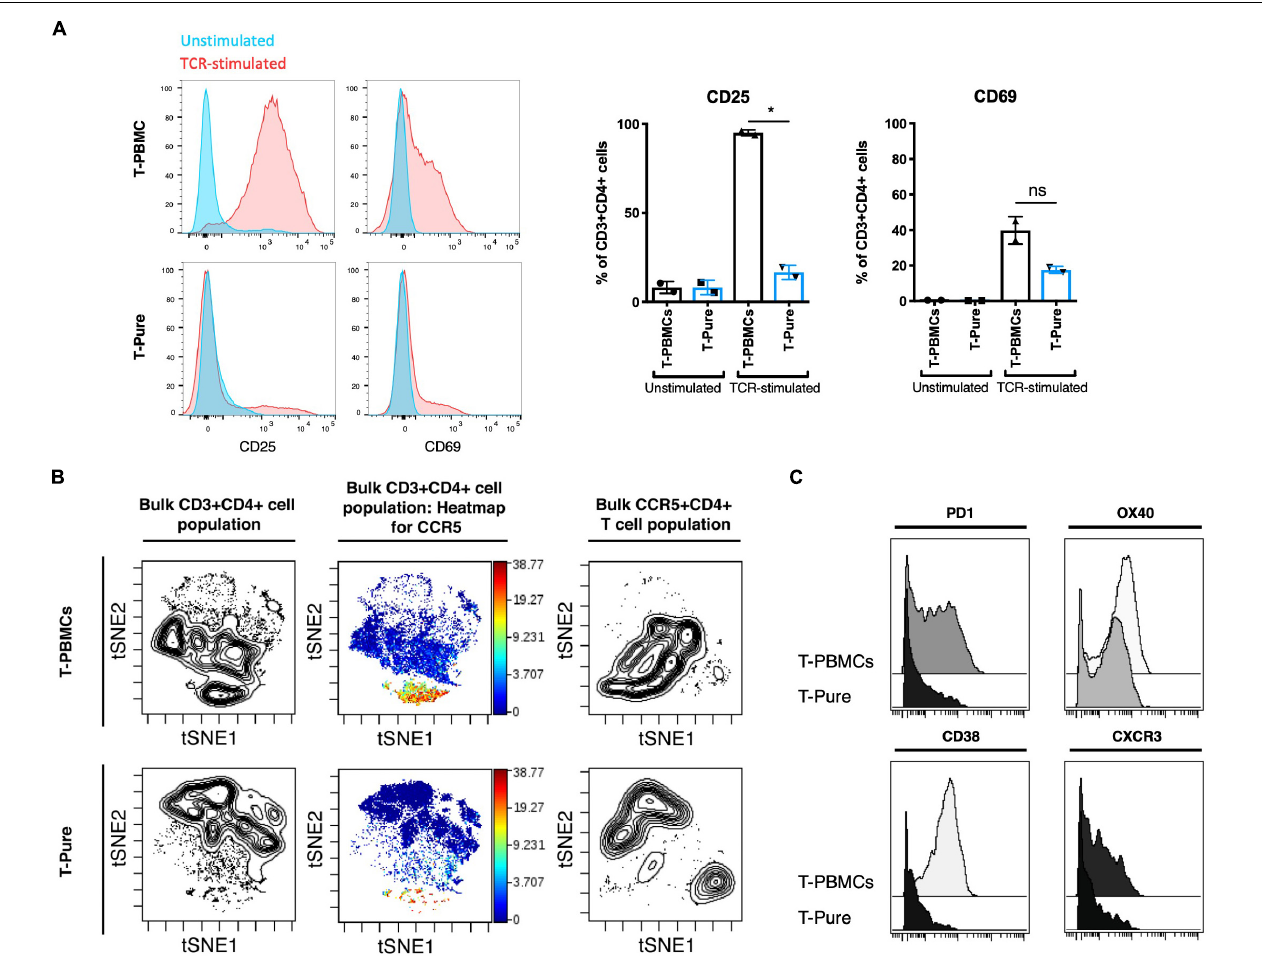
FIGURE 4 | T- peripheral blood mononuclear cells are more highly activated and phenotypically distinct from T-Pure cells. (A) Representative flow cytometry histogram showing expression of extracellular activation markers CD25 and CD69 on T-PBMCs and T-Pure cells that were TCR-stimulated or left unstimulated for 48 h followed by 24 h of rest without stimuli as described in Figure 1A . Graphs on the right show mean frequencies of CD25+ and CD69+ CD4+ T cells ( n = 2 donors). (B) T-PBMCs and T-Pure cells were analyzed using a 35-parameter CyTOF phenotyping panel, and results are presented as t-SNE plots. The first two contour plots on the left demonstrate that T-PBMCs (top) are different from those from T-Pure cells (bottom), as demonstrated by the cells residing in distinct regions of the tSNE plot. The same plots are then shown in heatmap fashion colored by expression levels of CCR5. Note the higher proportion of CCR5-expressing cells under the T-PBMCs culture conditions. The contour plots on the right correspond to a new tSNE analysis conducted on the CD4+ CCR5+ cells from the same donor sample. The CCR5+ CD4+ T cells from the T-PBMCs condition (top) reside in a distinct region of the tSNE plot relative to CCR5+ CD4+ T cells form the T-Pure condition (bottom), suggesting that the phenotype of CCR5+ CD4+ T cells are different under the two stimulation conditions. Two additional donors analyzed in a similar fashion are shown in Supplementary Figure 6A . (C) The CD4+ CCR5+ T cells from the T-PBMCs and T-Pure cultures were analyzed for expression of the activation markers PD1, OX40, CD38, and the T helper cell 1 marker CXCR3. Two additional donors analyzed in a similar fashion are shown in Supplementary Figure 6B . Statistical analysis was performed using a Paired students t -test. * P < 0.05. ns, not